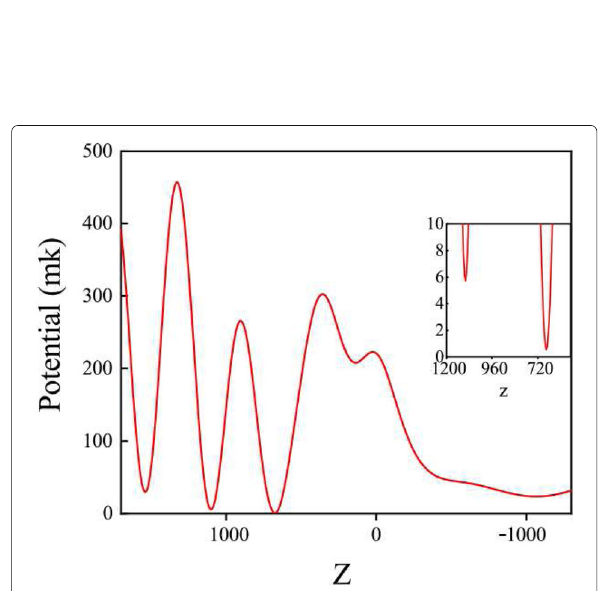
Fig. 4 Trapping potential in X - Z plane at Y = 0. The insert picture is the scale-up of the lowest trapping potential